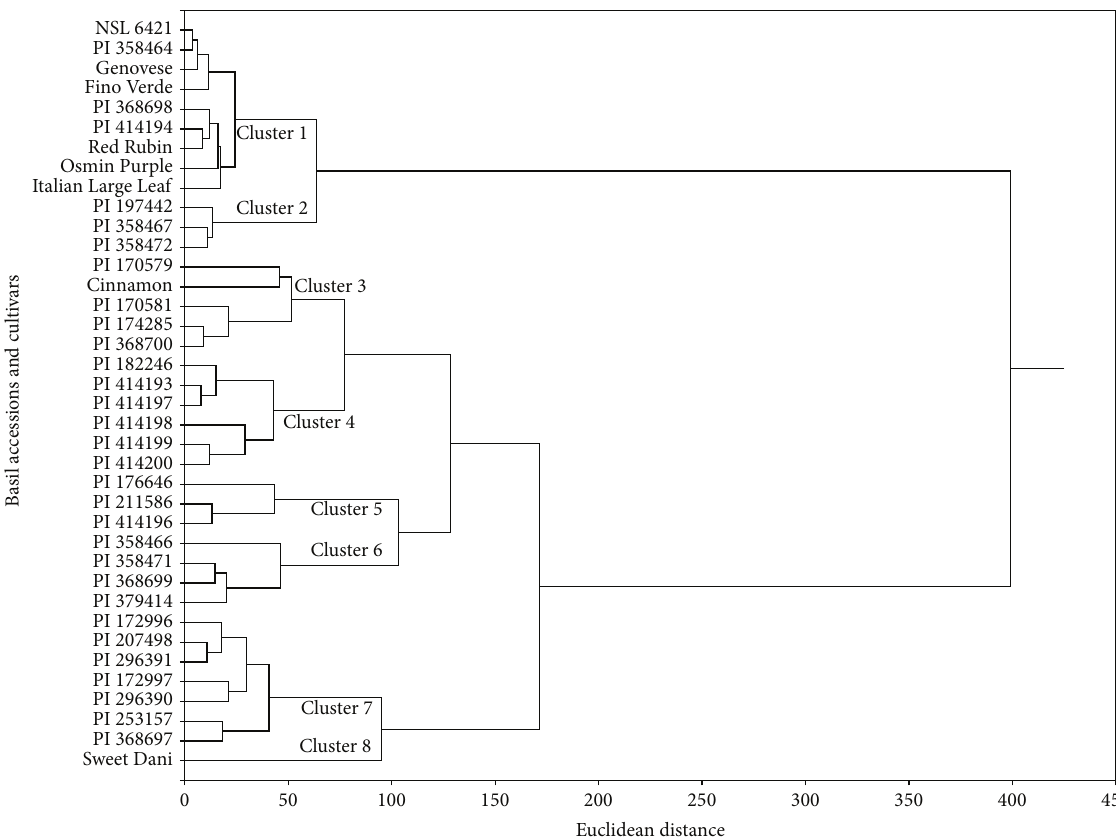
Figure1:Bidimensionaldendrogramrepresentingthesimilaritybetween31accessionsandsevencultivarsof Ocimumbasilicum forthechem- ical composition of the essential